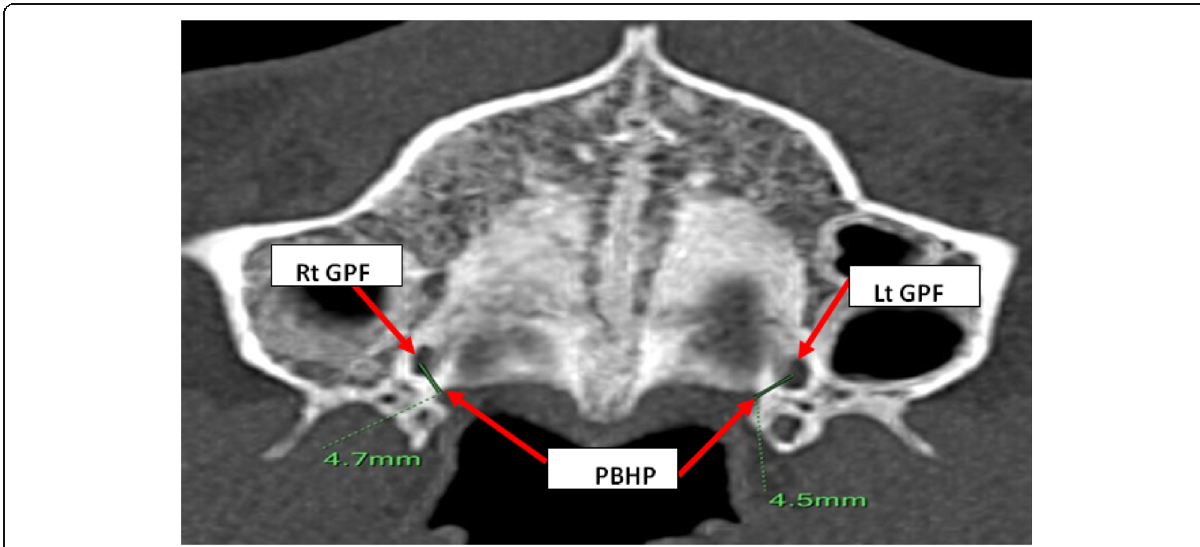
Fig. 9 A CT scan at the region of hard palate illustrating the shortest distance from the center of GPF to posterior border of hard palate (PBHP)